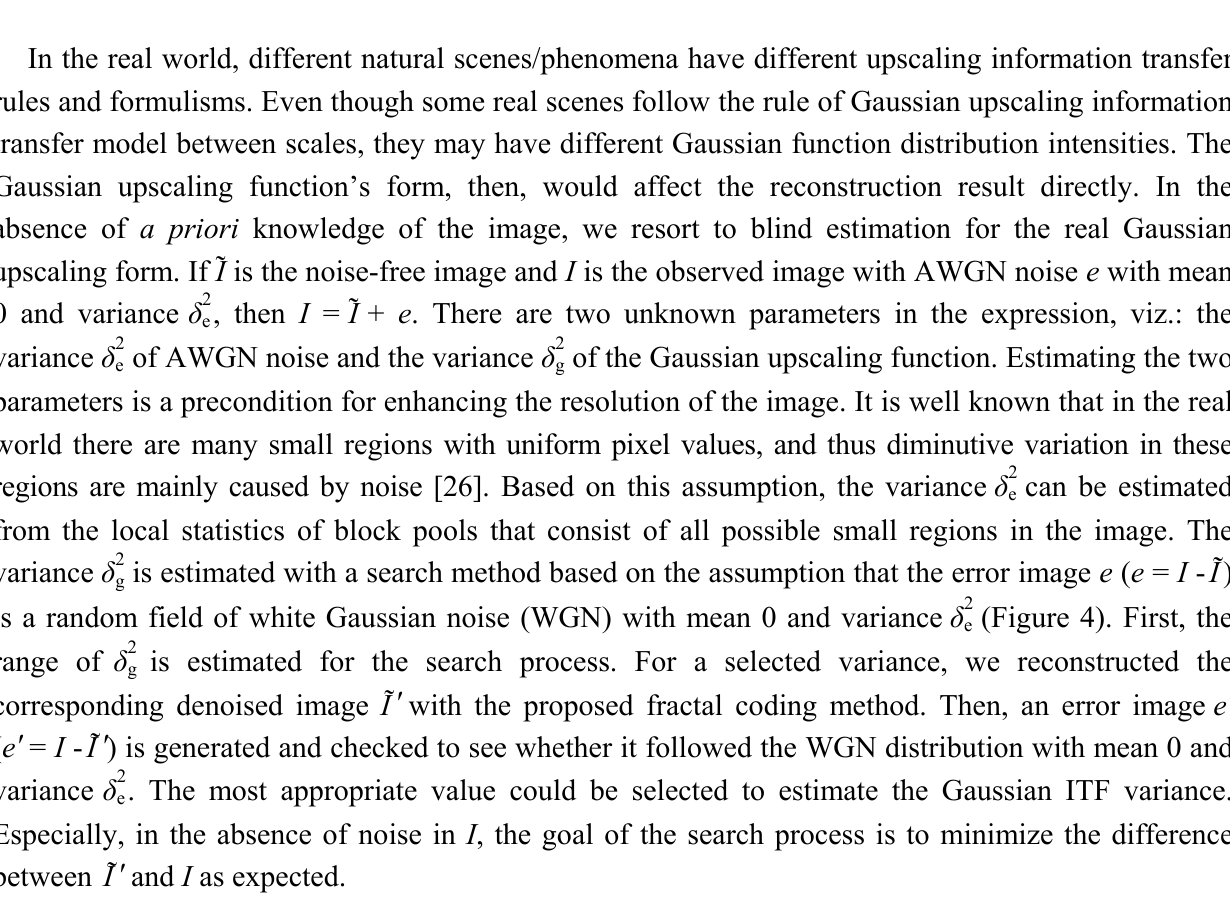
Figure 4. Work process to estimate the ITF